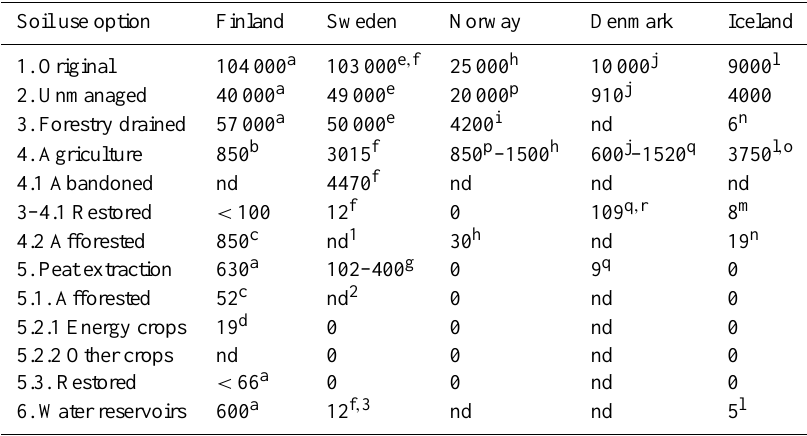
Table 1. Peatland areas in the Nordic countries (km 2 ). The “original” area represents the peatland area before human disturbance and the “unmanaged” the present area of undrained